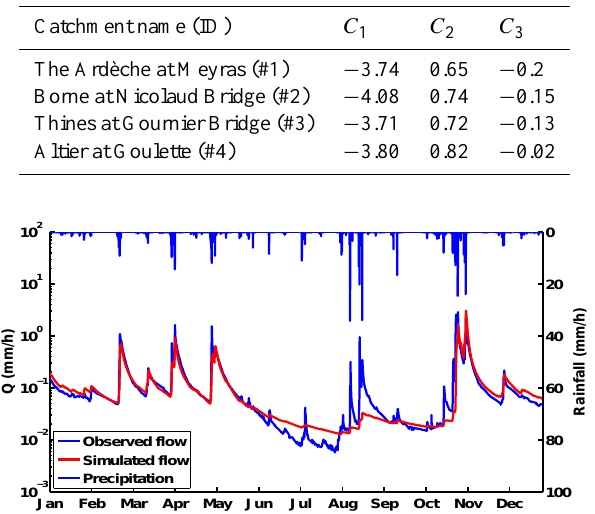
Table 6. Parameter values for the examined catchments for all low- vegetation periods (2000–2008).